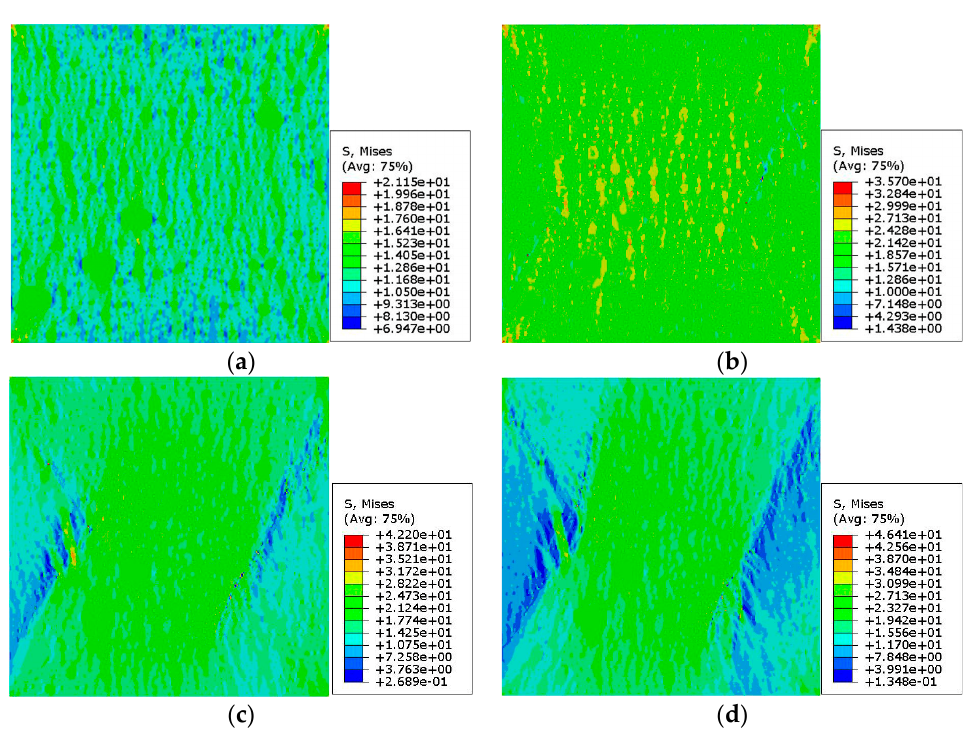
Figure 17. Stress nephogram of 2D RPA model for mortar (M2) with different strains: ( a ) ε = 0.03%; ( b ) ε = 0.1%; ( c ) ε = 0.3%; ( d ) ε = 0.45%.